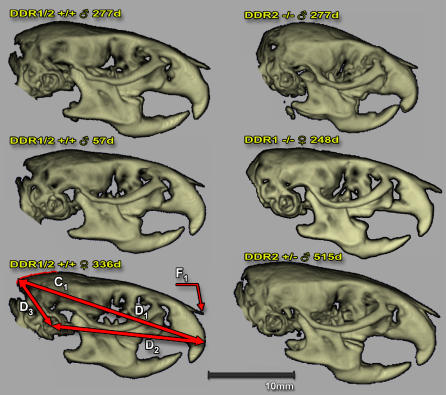
Comparison of Skull ImagePresented is a volume rendering of skull forms of C57BL/6 wild-type mice of different sexes and ages (left panel) and DDR2−/−, DDR1−/−, and DDR2+/− mice (right panel). Displayed are distances and representative features of the skeleton of the head viewed from the right side. D
1 represents the maximal distance between the external occipital protuberance and the incisor teeth. The distance between the center of the inner ear and the incisor teeth is labeled D
2, whereas D
3 delineates the distance between the center of the inner ear and the external occipital protuberance. C
1 depicts the bend of parietal, interparietal, and occipital bone and is measured as sum of the local contour curvature. The landmark F
1 symbolizes the nasal bone.